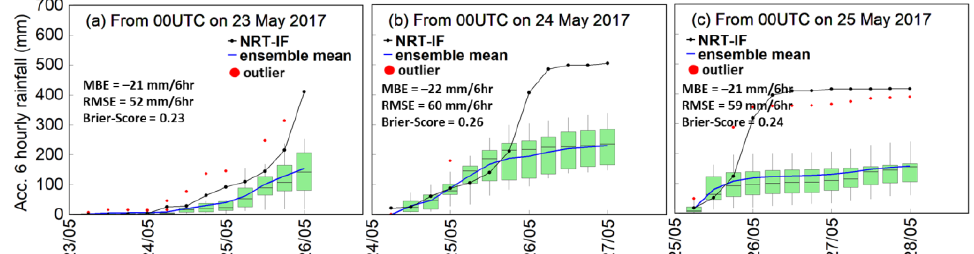
Figure 10. Comparison of basin-averaged 6-hourly accumulated ensemble rainfall with GSMaP-NRT-IF for 2017 flood event starting from ( a ) 00 UTC on 23 May; ( b ) 00 UTC on 24 May; and ( c ) 00 UTC on 25 May 2017. The green boxes indicate the 25th and 75th percentile values of the ensemble forecasts, black middle bars are for the median, and vertical lines are for maximum and minimum values.